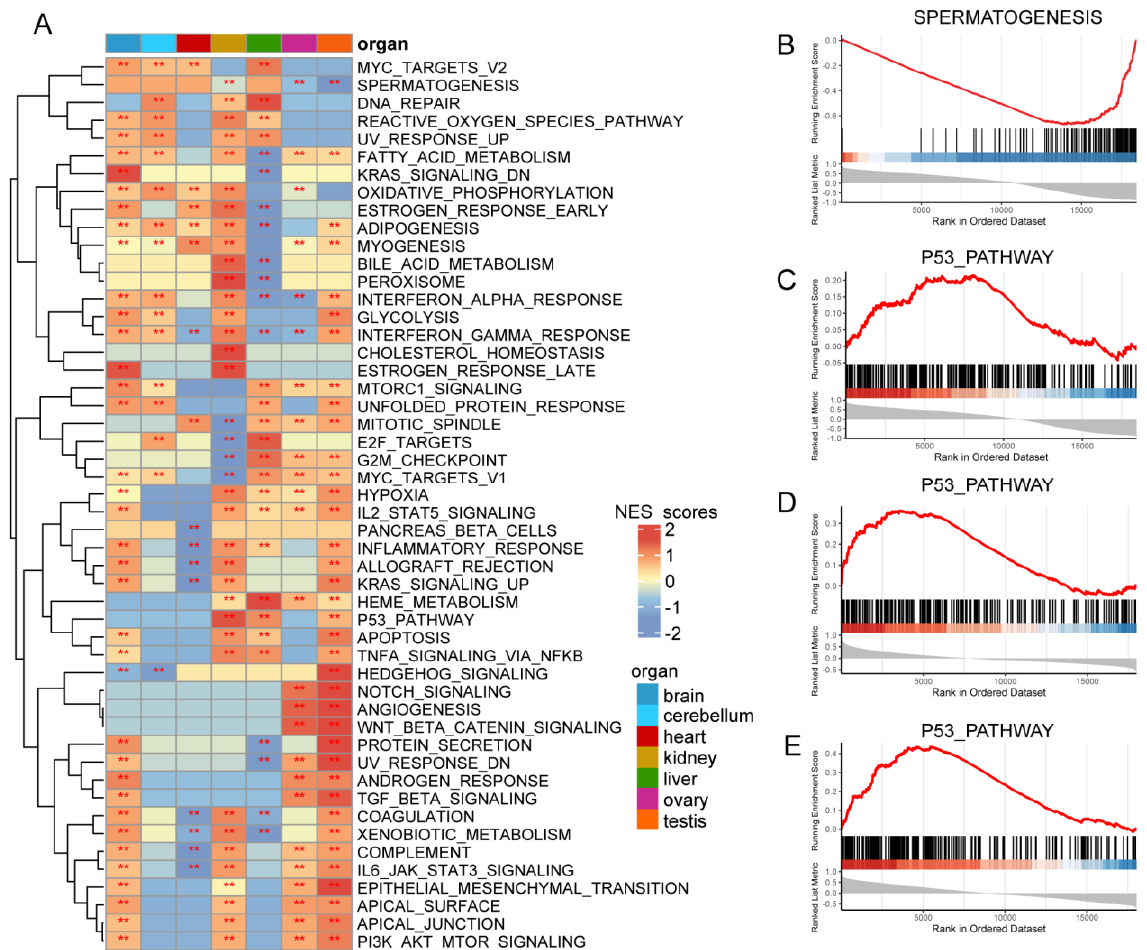
Figure 8. Gene set enrichment analysis of genes correlated with ZDHHC7 in different organs. ( A ) Heatmap exhibiting the normalized enrichment scores of GSEA. Functional pathways with FDR < 0.05 ware shown in red stars. Each column represents one organ and each row represents one cancer-hallmark-related pathway. ( B ) GSEA plots exhibiting genes correlated with ZDHHC7 in the spermatogenesis pathway in the testis. ( C ) GSEA plots exhibiting genes correlated with ZDHHC7 in the p53 pathway in the liver. ( D ) GSEA plots exhibiting genes correlated with ZDHHC7 in the p53 pathway in the testis. ( E ) GSEA plots exhibiting genes correlated with ZDHHC7 in the p53 pathway in the kidney. ** represents p -adjust < 0.05 for GSEA.